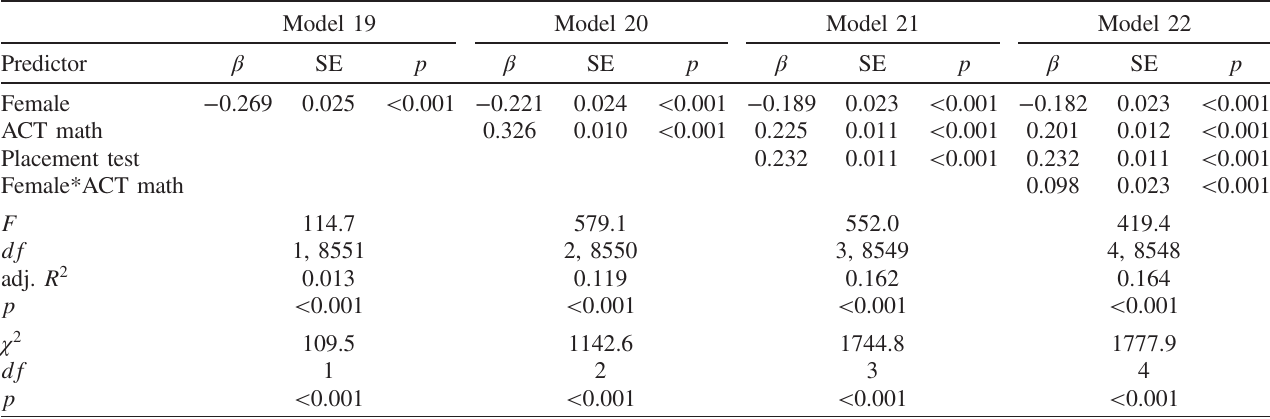
TABLE XVI. Binary gender models predicting physics 1 final exam scores. Female is coded as 1 and male is coded as 0 for the gender variable. Continuous variables are